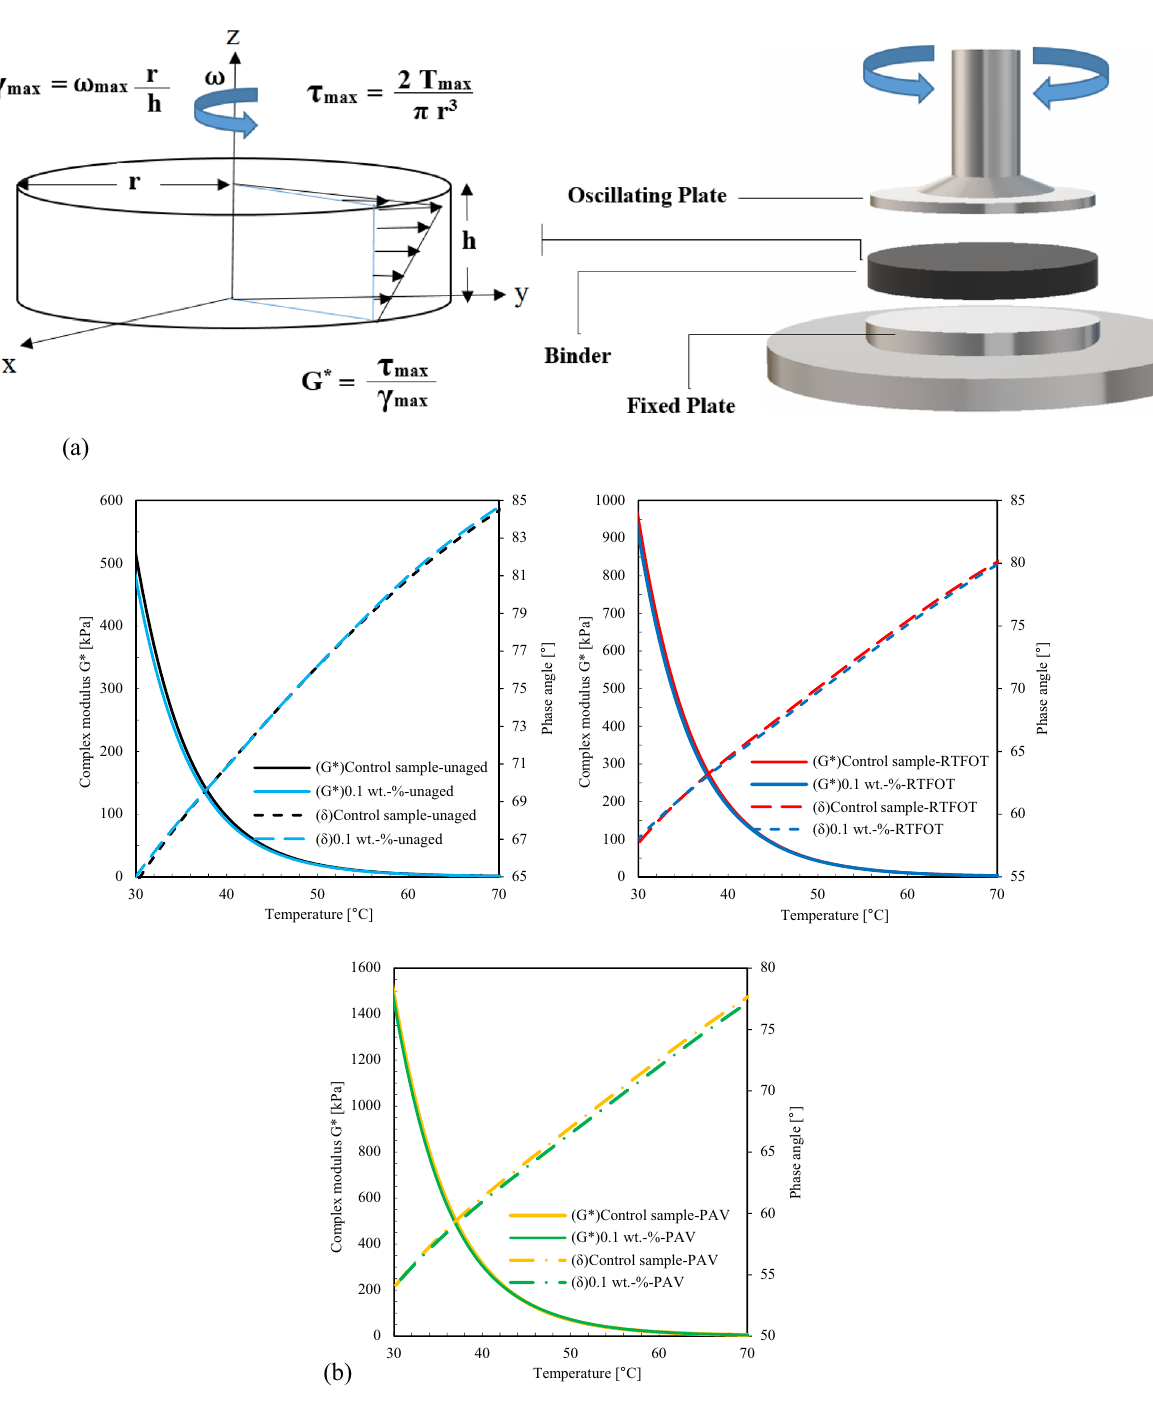
Figure 2. Analysis of Dynamic Shear Rheometer tests: ( a ) Schematic of rotational plate viscosity test. Complex modulus and phase angle of binders modified by fumed silica nanoparticles (FSN) before and after laboratory aging with ( b ) 0.1 wt.-%, ( c ) 2 wt.-%, and ( d ) 3 wt.-% of